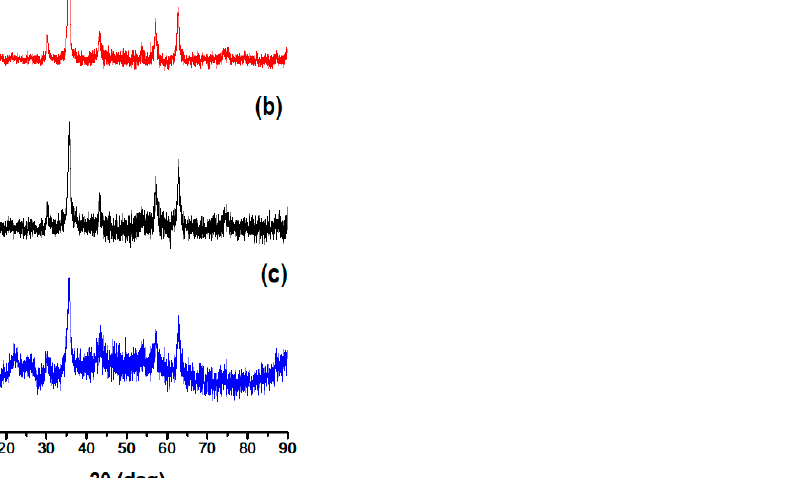
Figure 4. XRD spectra of ( a ) pristine SPIONs, ( b ) CLA-coated SPIONs, and ( c ) CLA-coated PTX- SPIONs showing the crystalline nature of the SPIONs before and after the CLA coating and PTX loading.